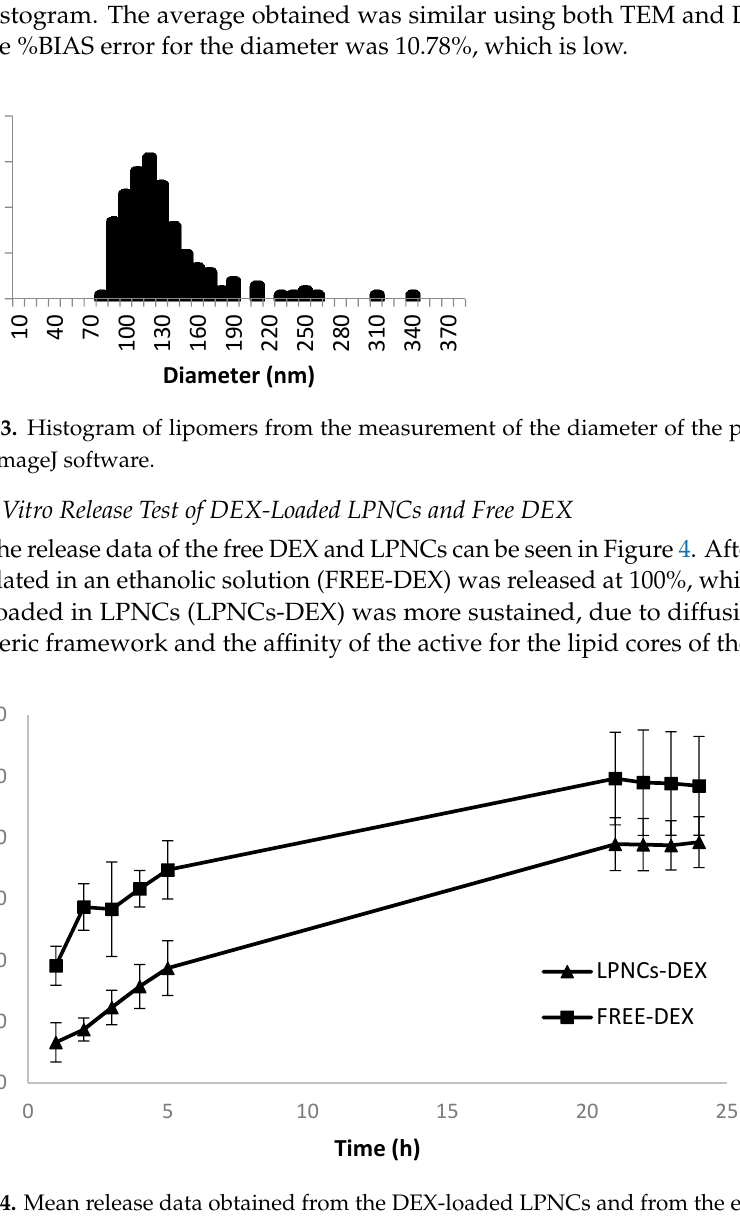
Figure 2. Transmission Electron Microscopy (TEM) images of negative-stained lipid–polymer hy- brid LPNCs with 2% uranyl acetate at ( a ) ×250,000 magnification; and ( b ) ×300,000 magnification. ( c ) Individual nanoparticle representation zoom.